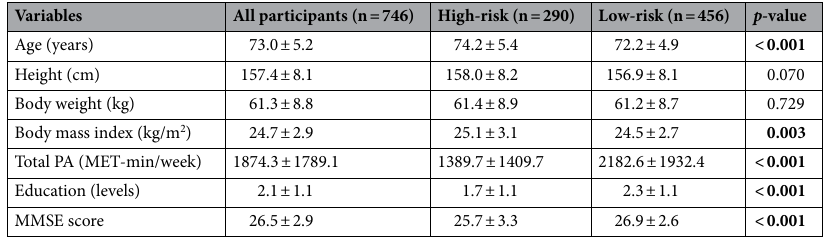
Table 1. Demographic characteristics of participants. Mean ± SD mean and standard deviation, PA physical activity, METs metabolic equivalents, MMSE mini-mental state examination; the level of education was defined as a categorical variable [elementary school education or less (education level 1), middle school education (education level 2), high school education (education level 3), college degree (education level 4), or higher (education level 5)]; boldface denotes a significant difference between high- and low-risk of falls; significant difference: p <